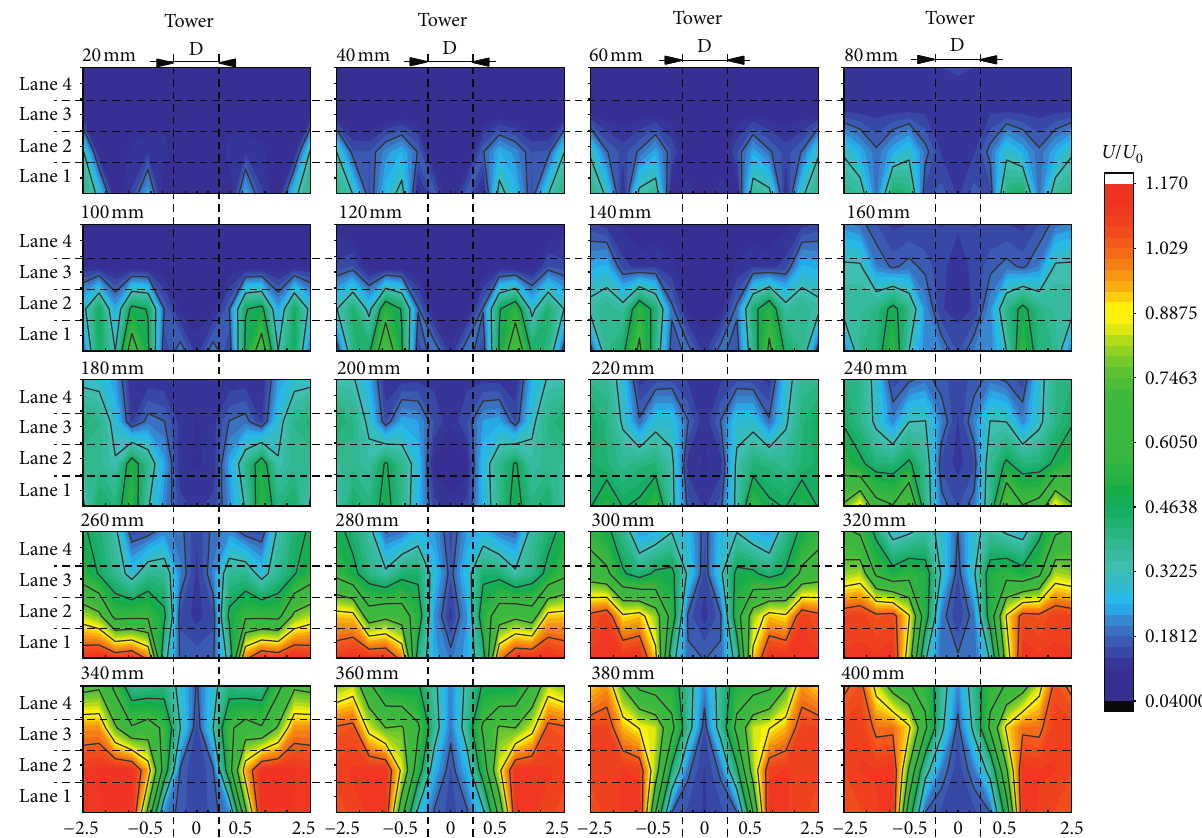
Figure 9: Contours of wind field above the bridge deck in the presence of WB-2